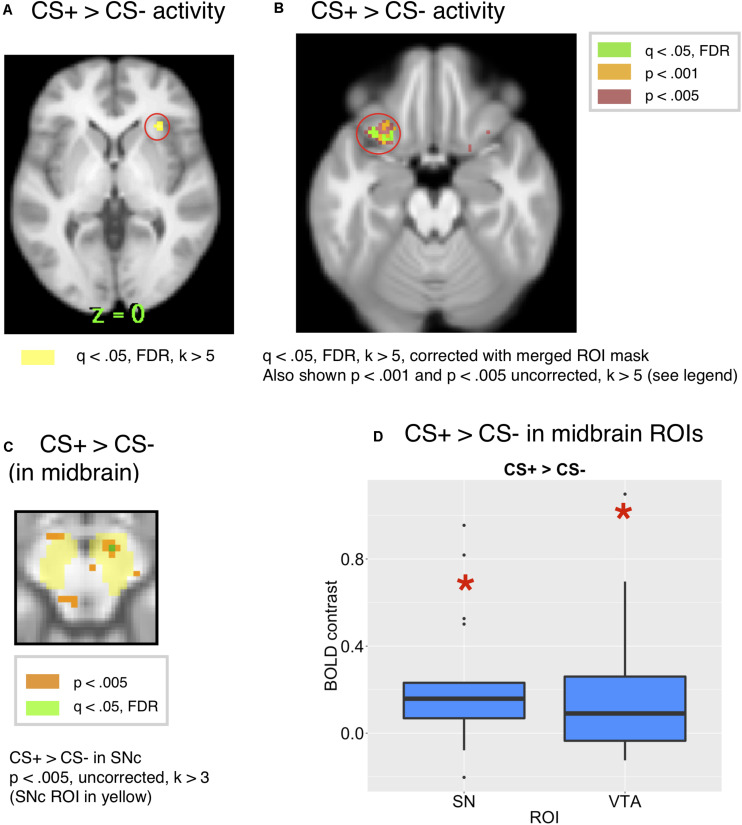
(A) Whole-brain activity for the CS+ compared to CS– showed activity in the insula at q < 0.05, FDR. (B) Comparing the whole brain activity for the CS+ to that for the CS–, there was activity in the OFC (x = 24, y = 18, z = 20, t = 5.91, k = 8 and x = –34, y = 20, z = 20, t = 5,46), corrected across the all-ROI mask. (C) CS+ > CS– in the SN/VTA, p < 0.005, uncorrected. (peak: 8, –14, –12, k = 7, t = 8.85). (D) The ROI analysis showed significant activity in the SNc [t(18) = 3.17, p = 0.0053, Bonferroni p = 0.053) and VTA [t(18) = 2.58, p = 0.0189, Bonferroni p = 0.189] for the CS+ compared to the CS–.